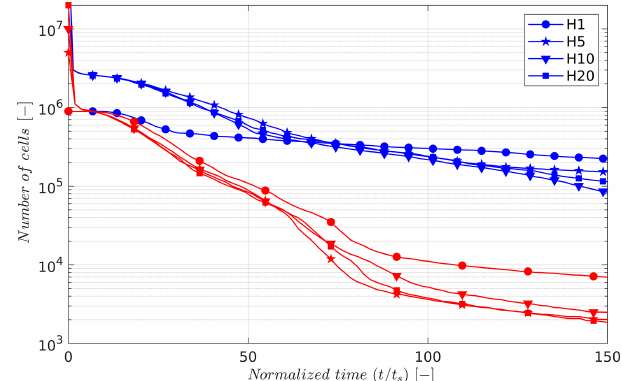
Figure 13. Total number of eDS-type cells left in the simulation as a function of time for different Hα cases. Lines are coloured to represent the high-wind (UH, blue) and medium-wind (UM, red) scenarios. Note that the y axis is